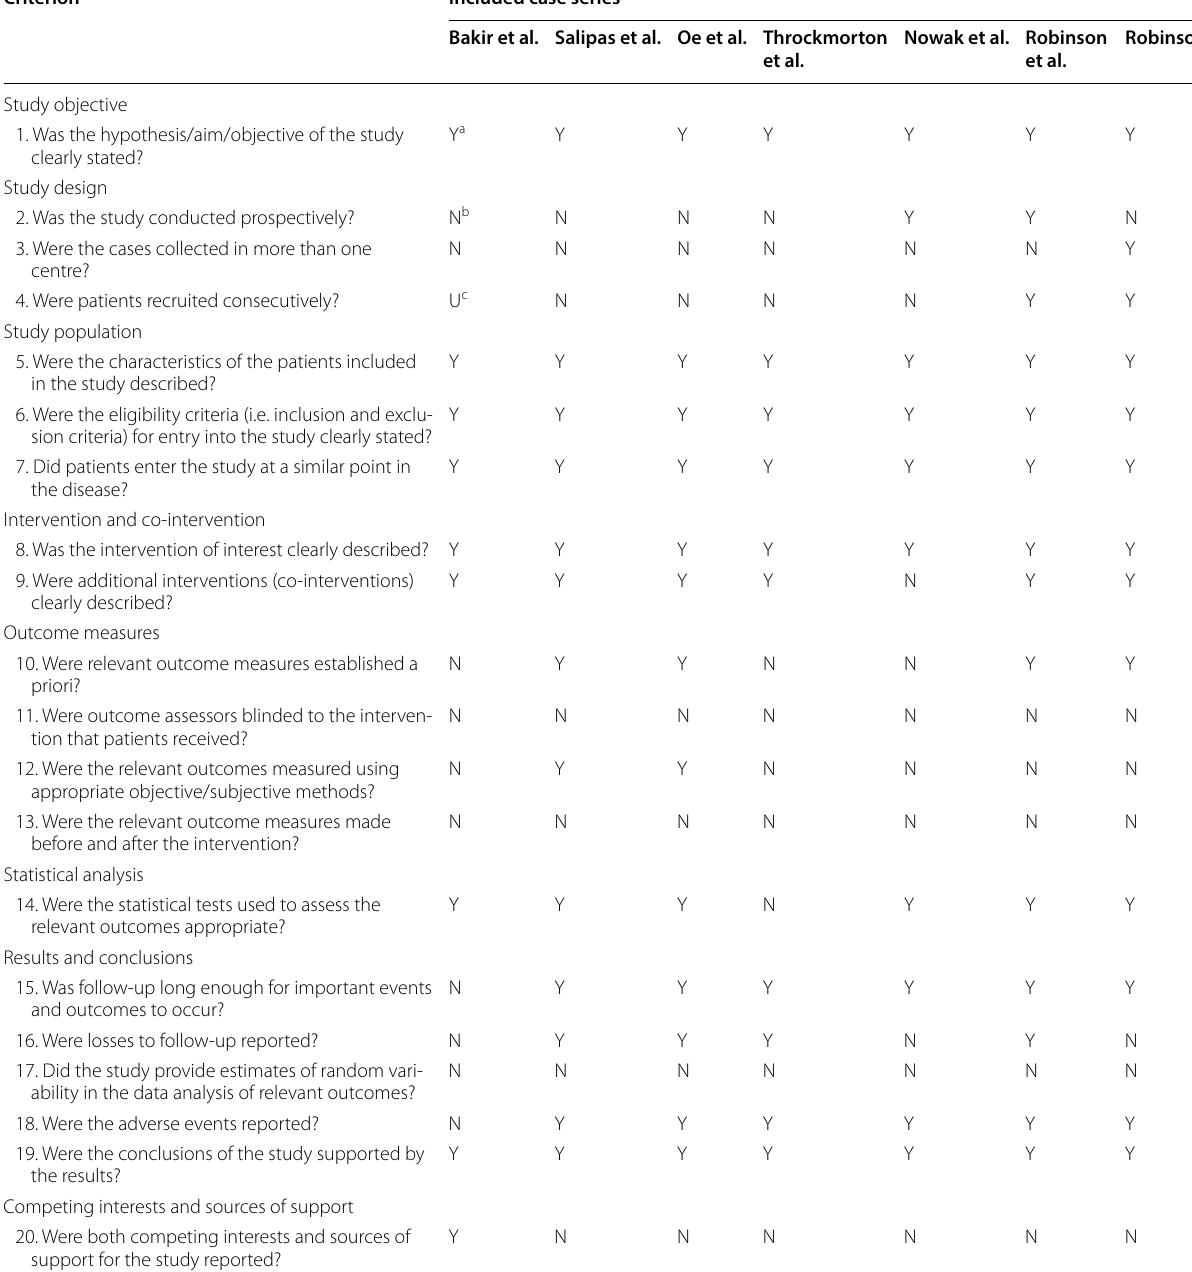
Table 2 Completed IHE checklist for case-series